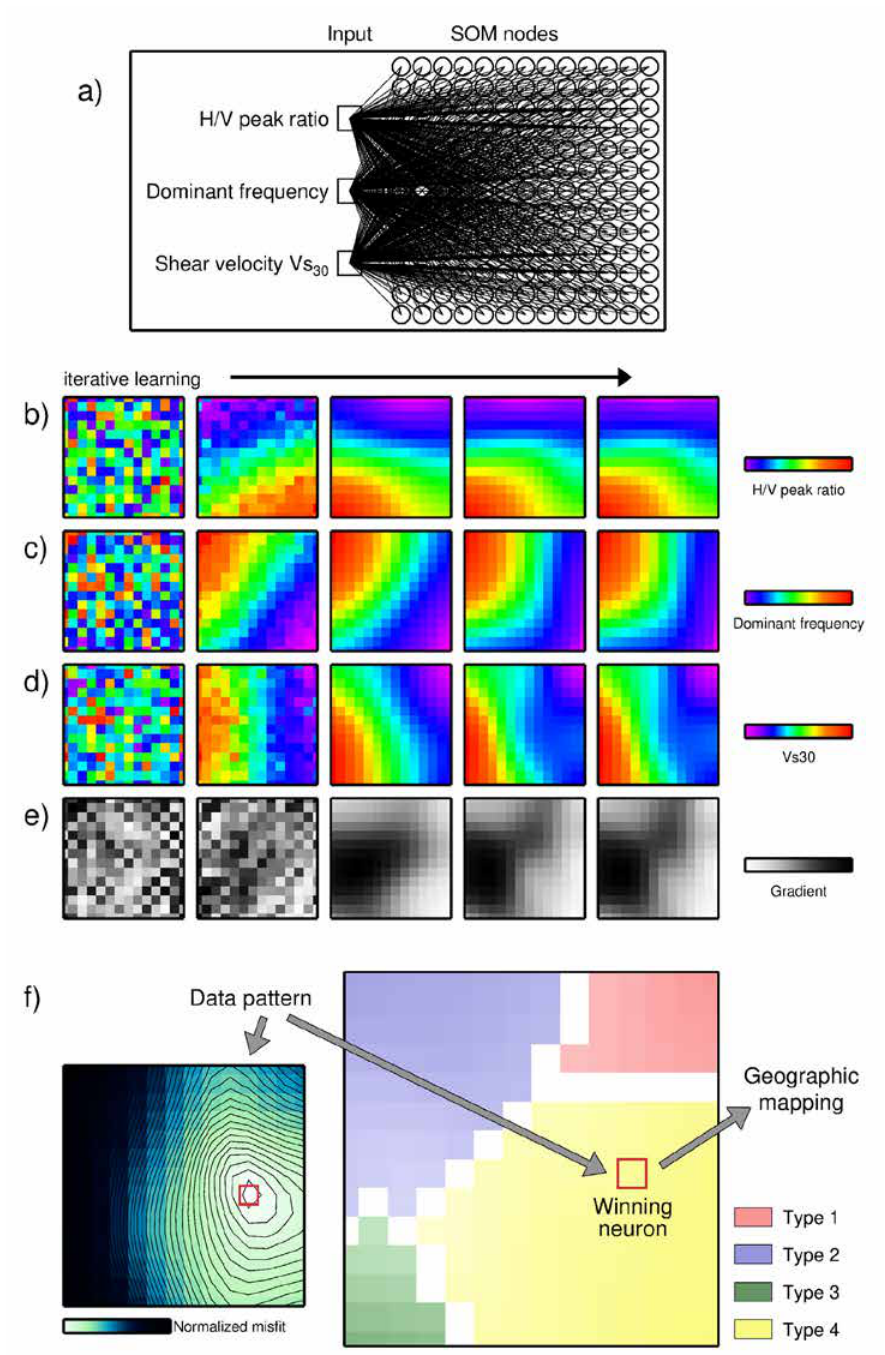
Fig. 5: (a) Design of the SOM which includes the input layer and a two-dimensional layout of SOM nodes. Evolution of the different components of the neural model vector (b-d) and the corresponding gradient function (e) during iterative learning. (f) Segmentation of the trained SOM. All input data patterns are classified based on the assignment of the winning neuron. The detection of the winning neuron is based on the evaluation of the normalized misfit function for a given data pattern vector. The associated color code is used in the geographic mapping of each input data pattern.